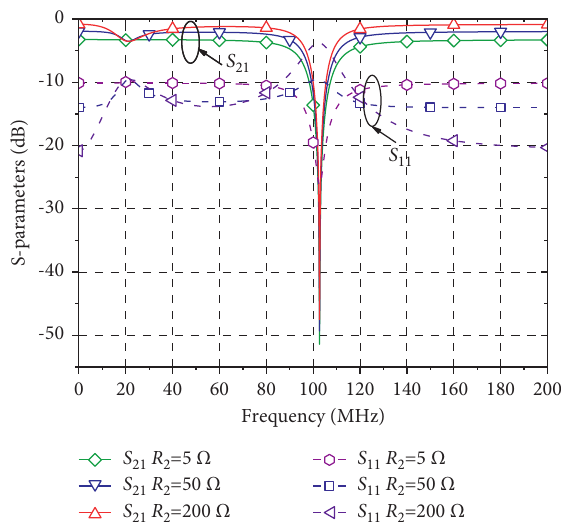
Figure 15: S parameters of the band-stop filter with negative band-pass delay at different R Table 8: Element values of low-pass negative group delay circuits with different values of L